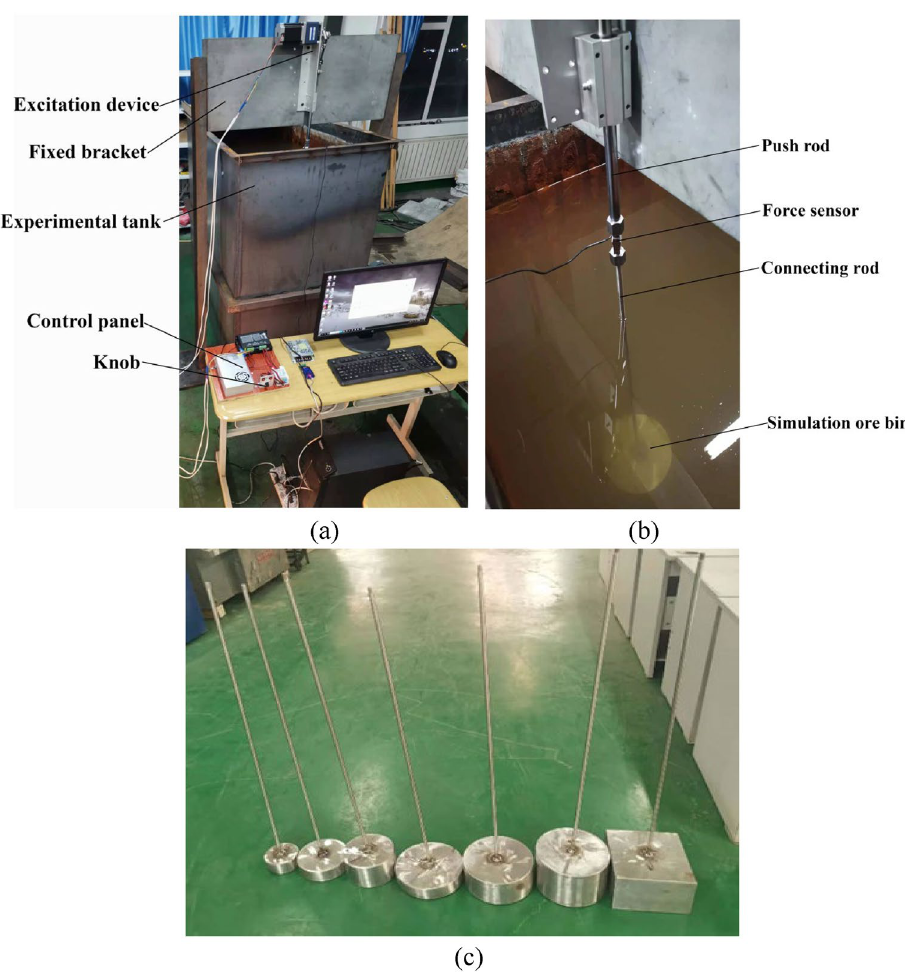
Figure 2. Composition diagram of experimental test